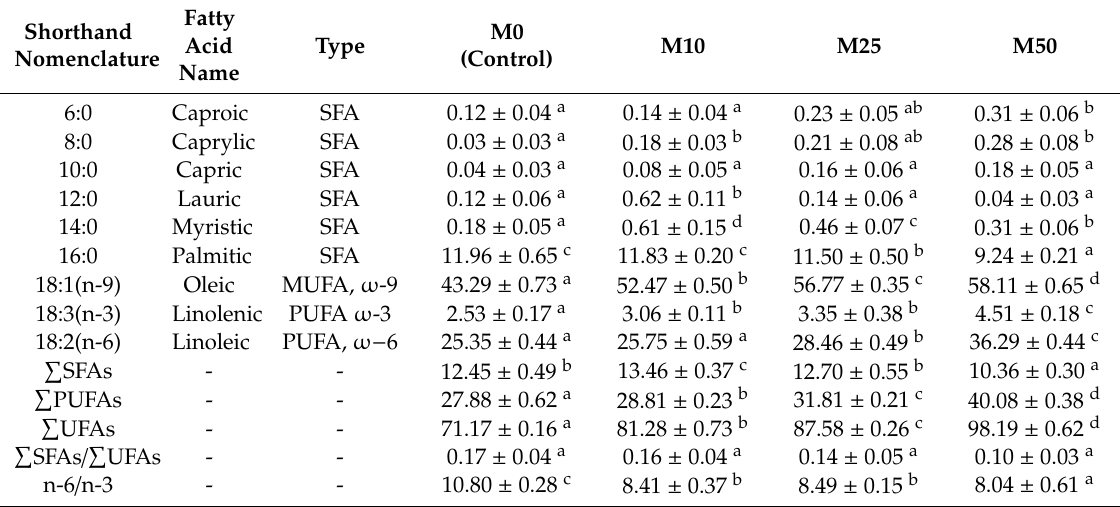
Table 5. Fatty acids methyl esters content (% of total fatty acids methyl esters) of macaron samples.